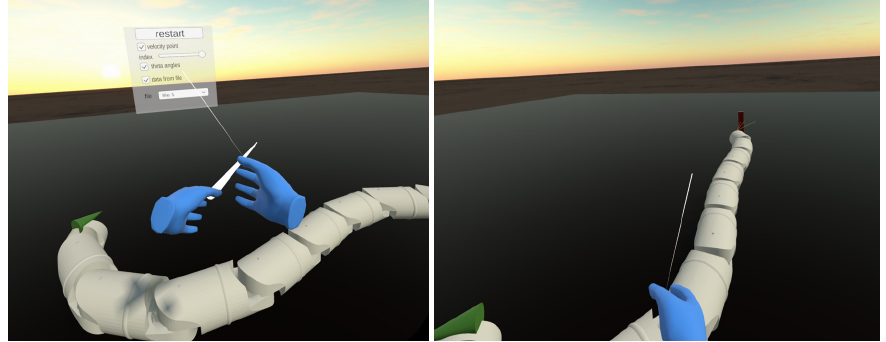
Figure 3. Virtual scene with the snake robot implemented in Unity.